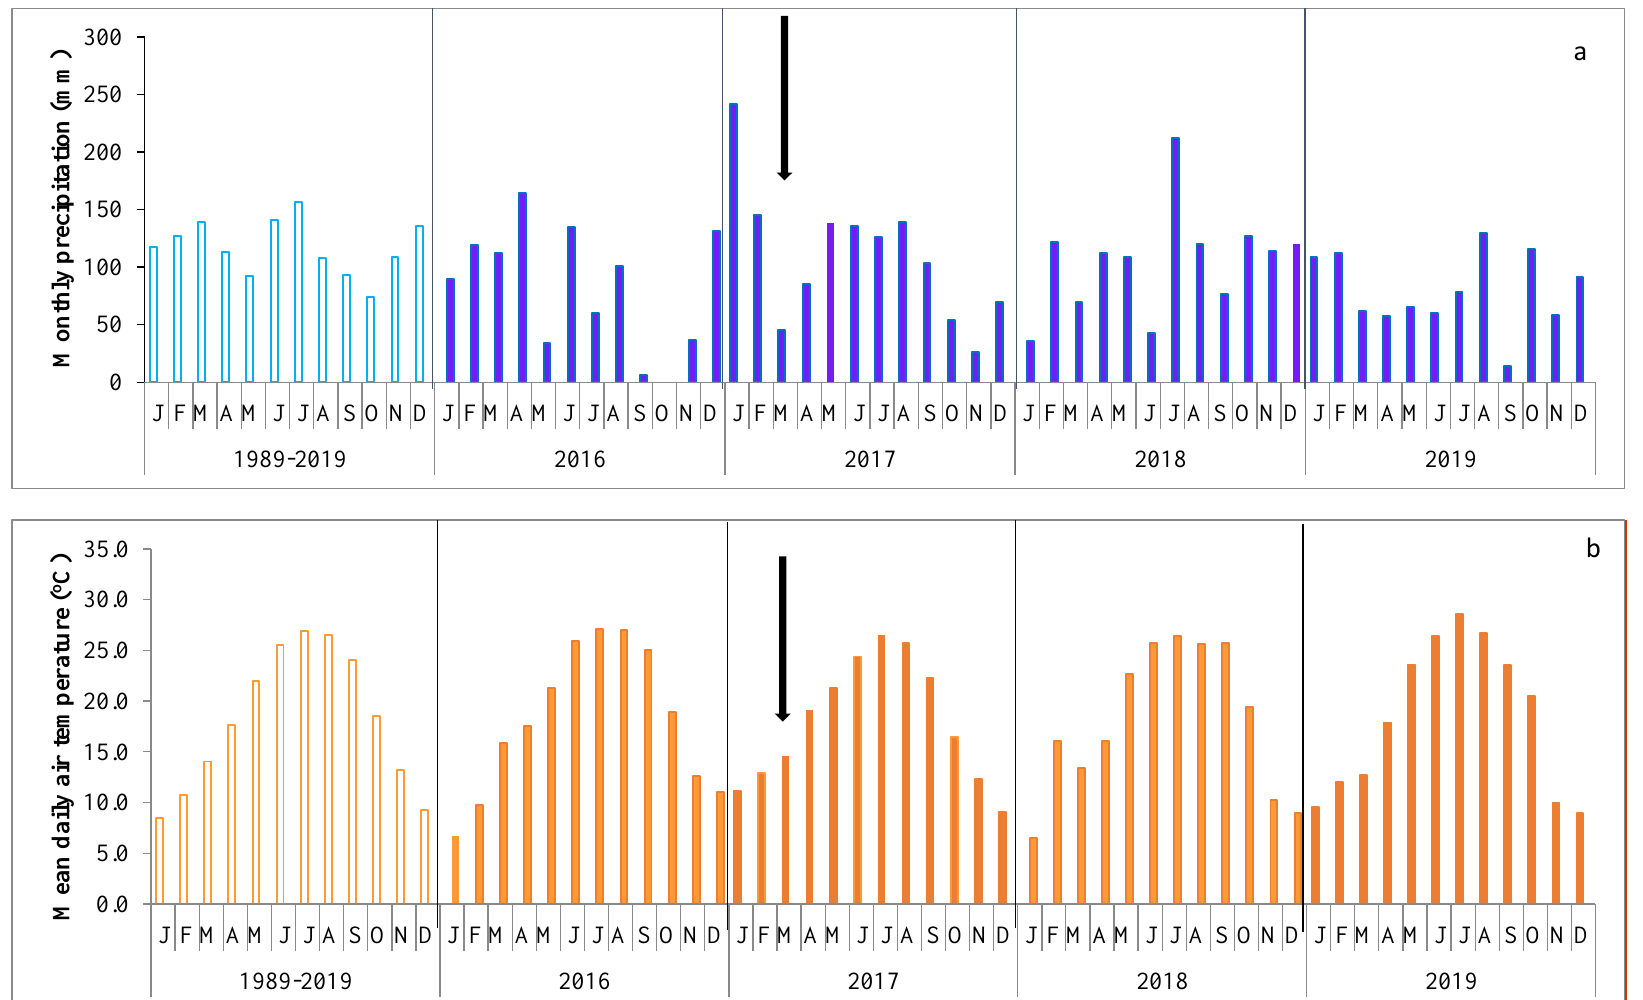
Figure 1. Monthly precipitation ( a ) and mean daily air temperature ( b ) at the study site near Eufaula, AL, from 2016 to 2019 (filled bars) and 30-year averages of these climatic variables (unfilled bars) between 1989 and 2019 [42]. Arrows indicate the time of inoculation treatment.